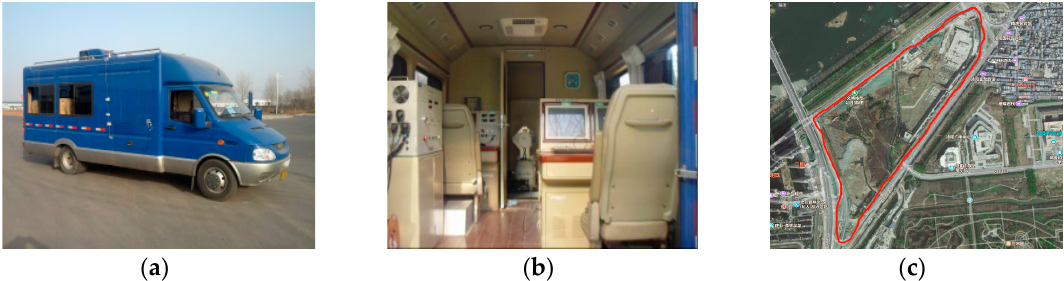
Figure 13. Test platform. ( a ) Mobile test vehicle, ( b ) internal test equipment, and ( c ) trajectory on map shown by the red line.